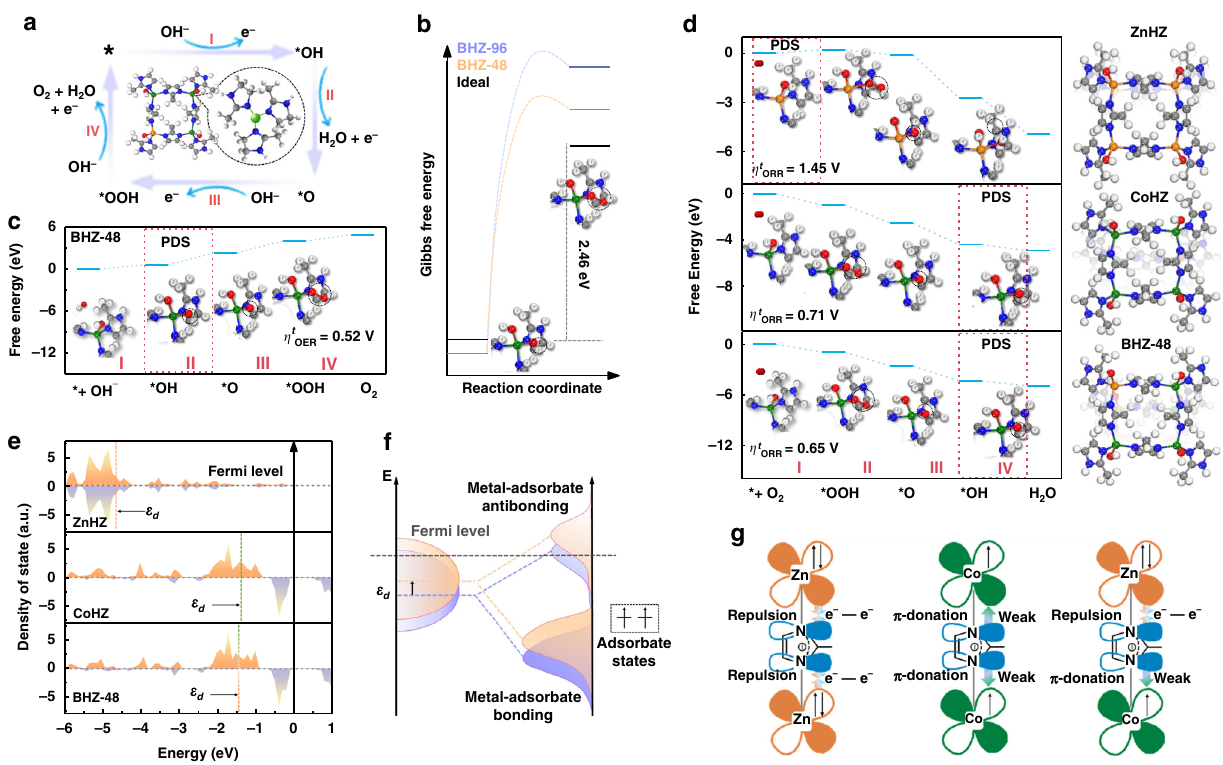
Fig. 6 DFT simulations and proposed mechanism illustration. a Proposed OER catalytic mechanisms for BHZ-48. b Calculated energy barriers of the *OH transformation to *OOH at active sites of BHZ-48 and BHZ-96. Gibbs free-energy diagram for c OER of BHZ-48, d ORR of ZnHZ, CoHZ, and BHZ-48 with corresponding top views of the structures. Blue, gray, white, red, green, and orange balls represent the N, C, H, O, Co, and Zn atoms, respectively. e the calculated d band density of state for the transition metal atoms in ZnHZ, CoHZ, and BHZ-48. f Schematic illustration explaining change of metal- adsorbate interaction by altering the metal d band center ( ε d ). g Schematic representations of the electronic coupling between Co and